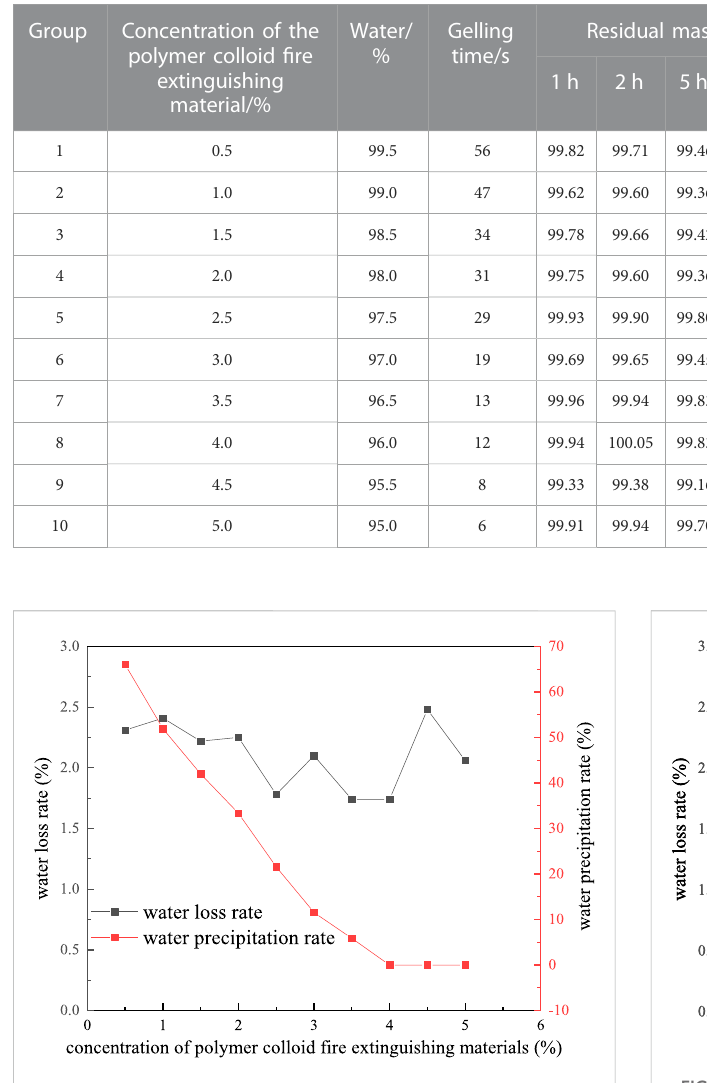
FIGURE 5 Changes in the water loss rate and water precipitation rate of the polymer colloid fi re extinguishing agentwith differentconcentrations.